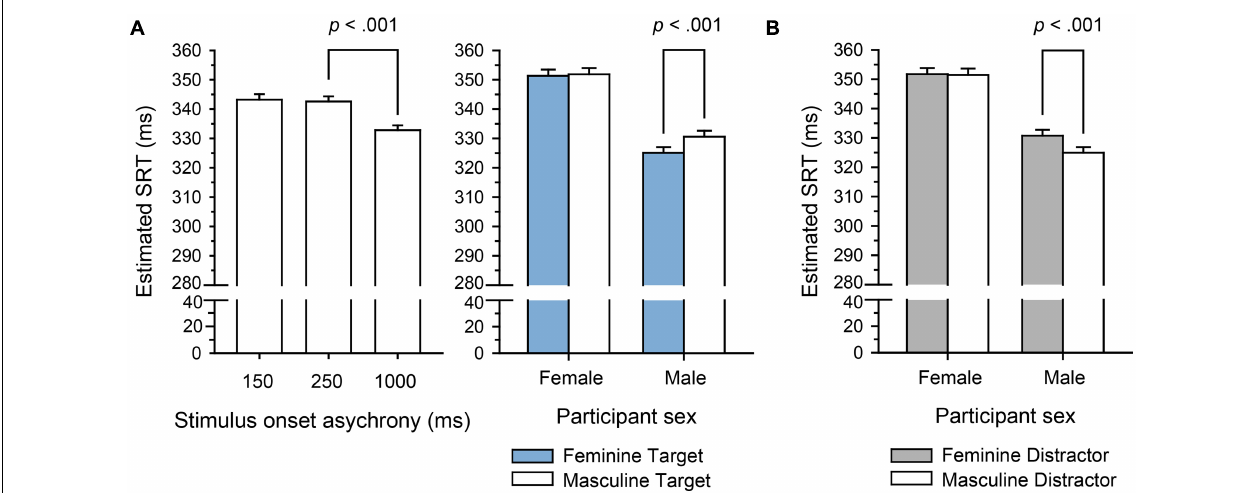
gender. For male participants, SRTs were shorter when the face at the target location was feminine. (B) Model results for the distractor face cues. The model yielded a significant interaction of participant sex and distractor face cue gender. For male participants, SRTs were longer when there was a feminine face at the distractor location (the SOA effect is not depicted for the distractor model as it was qualitatively identical to the target model).